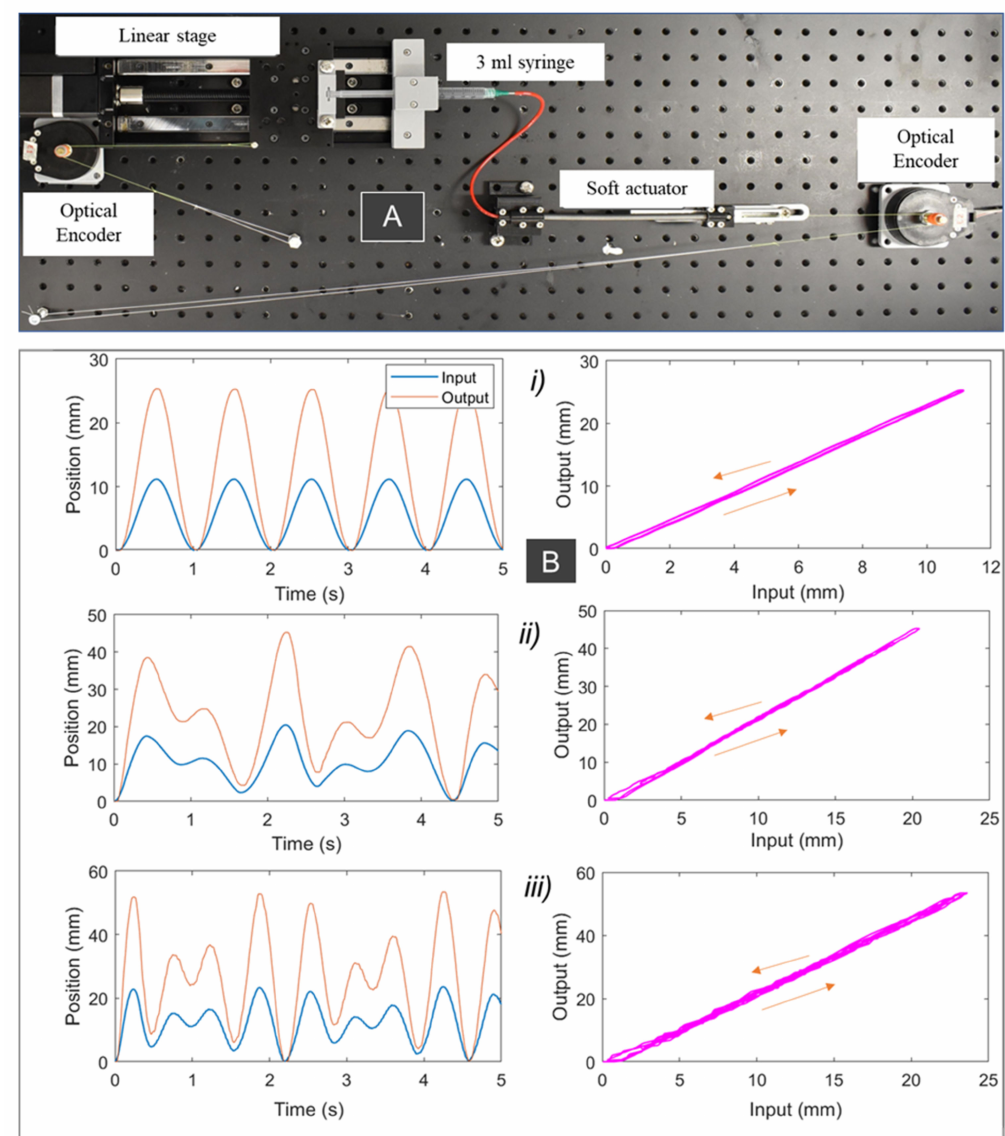
Figure 3. Experimental results for the soft actuator (SA1). ( A ) Experimental setup. ( B ) Different input signals applied to the syringe plunger. They include 1 Hz sine wave input ( i ); two pairings of sine waves (combined frequency of 1 Hz and 1.7 Hz) ( ii ); and two pairings of sine waves (combined frequencies of 2 Hz and 2.7 Hz ( iii )) with amplitudes scaled to produce 0 to 30% elongation. ( Left panel ) time history of the input and output displacement. ( Right panel ) input displacement versus output displacement (or the SA1